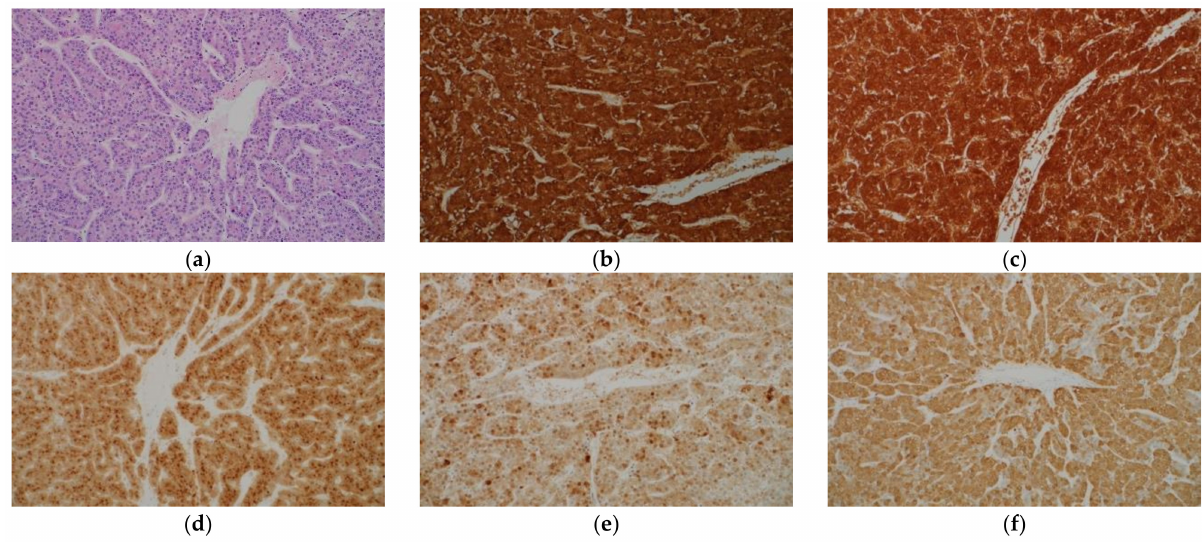
Figure 1. Histological appearance ( a ) and results of immunohistochemical staining ( b – f ) of hepatocellular carcinoma. ( a ) Tumor cells resembling hepatocytes proliferate, showing thick trabecular growth pattern. On immunohistochemistry, the tumor cells are positive for hepatocyte paraffin 1 ( b ), arginase-1 ( c ), glypican-3 ( d ), heat shock protein 70 ( e ), and glutamine synthetase (GS) ( f ). (Original magnification: × 200 for ( a – f )).